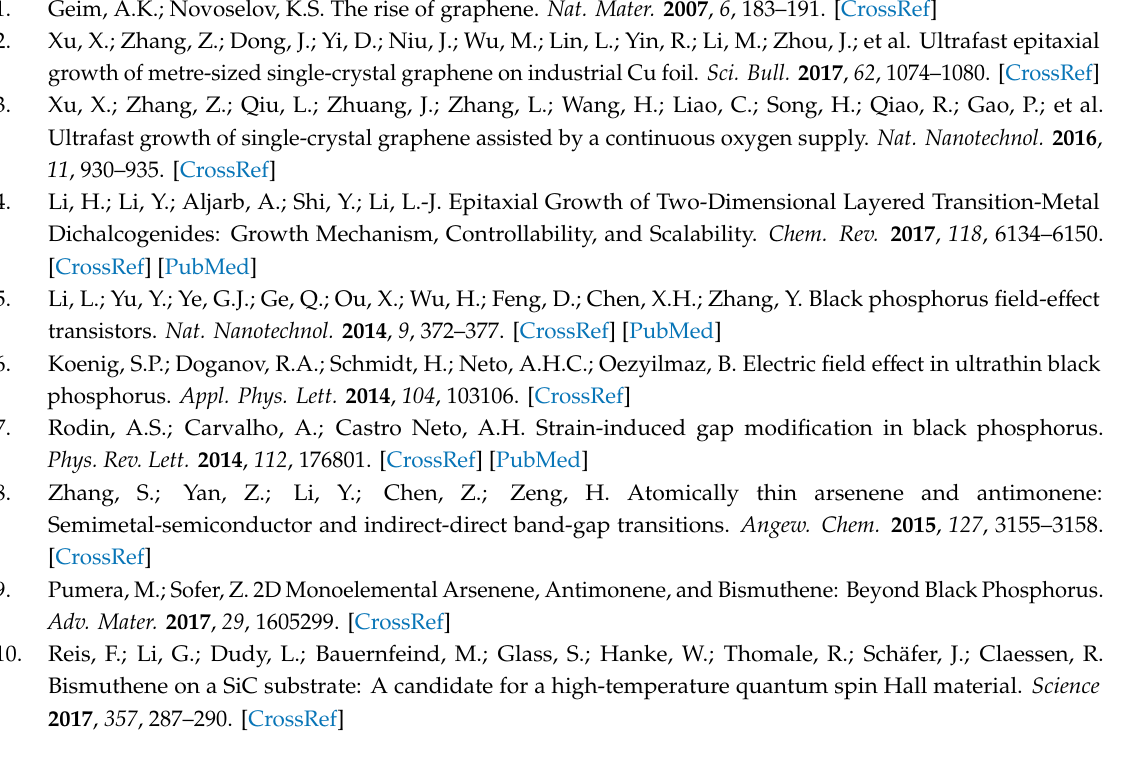
Figure S1: AFM image of sample A-1 and the height profile cross the film and the substrate, Figure S2: AFM image of sample A-4 and the profile of one line scan. (unit: